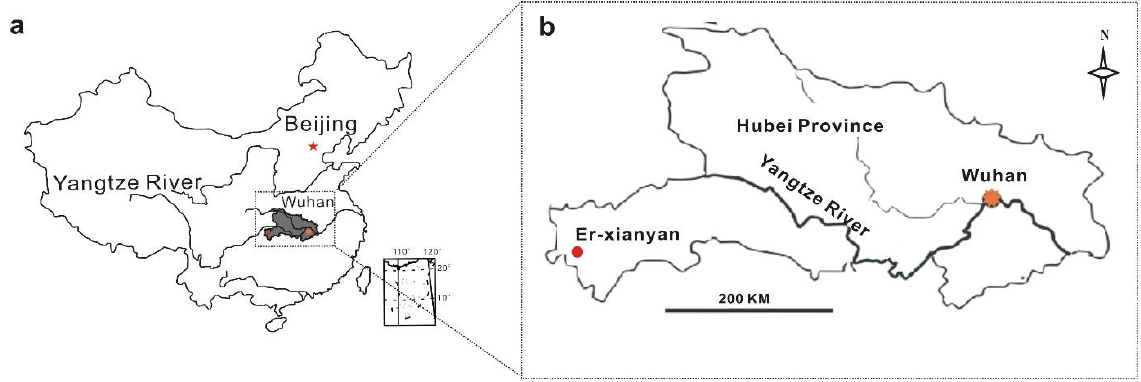
Figure 1. Location of study area ( a ) and sampling site ( b ) in the Erxianyan peatland, central China.